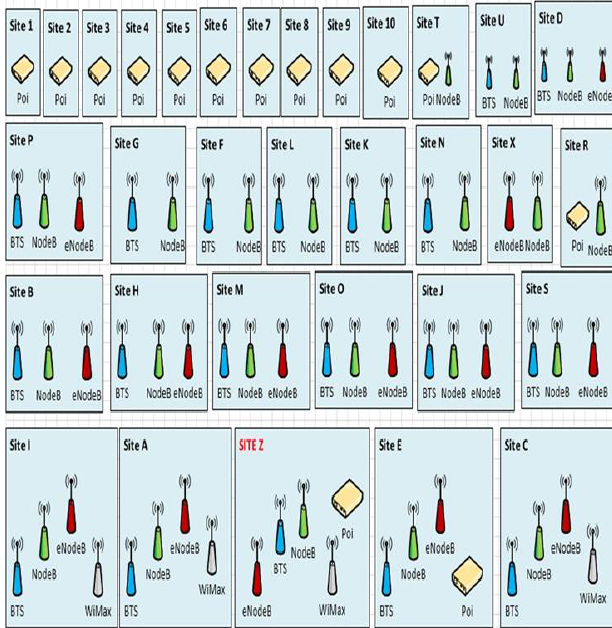
Figure 1. The equipment used and traffic generated on each